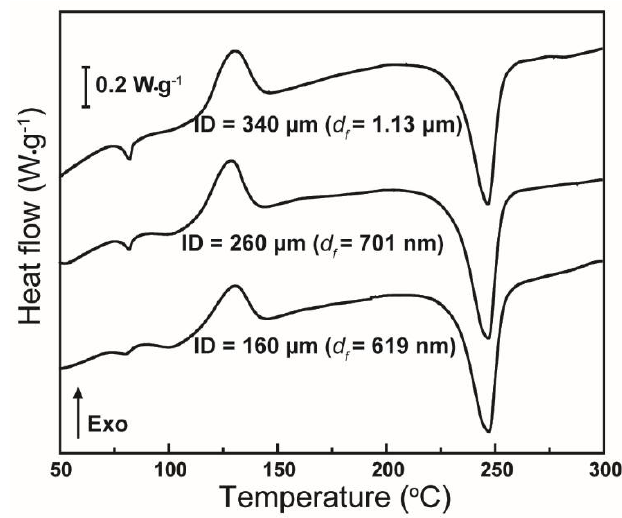
Figure 11. Differential scanning calorimetry thermograms of fibers mats with various average diameters ( d f ) produced using needles with various inner diameters. Centrifugal spinning condition: polymer solution concentration, 10 wt %; rotational speed, 15,000 rpm; collection distance, 10 cm. Table 4. Thermal properties of rPET fibers prepared using needles having various inner diameters.